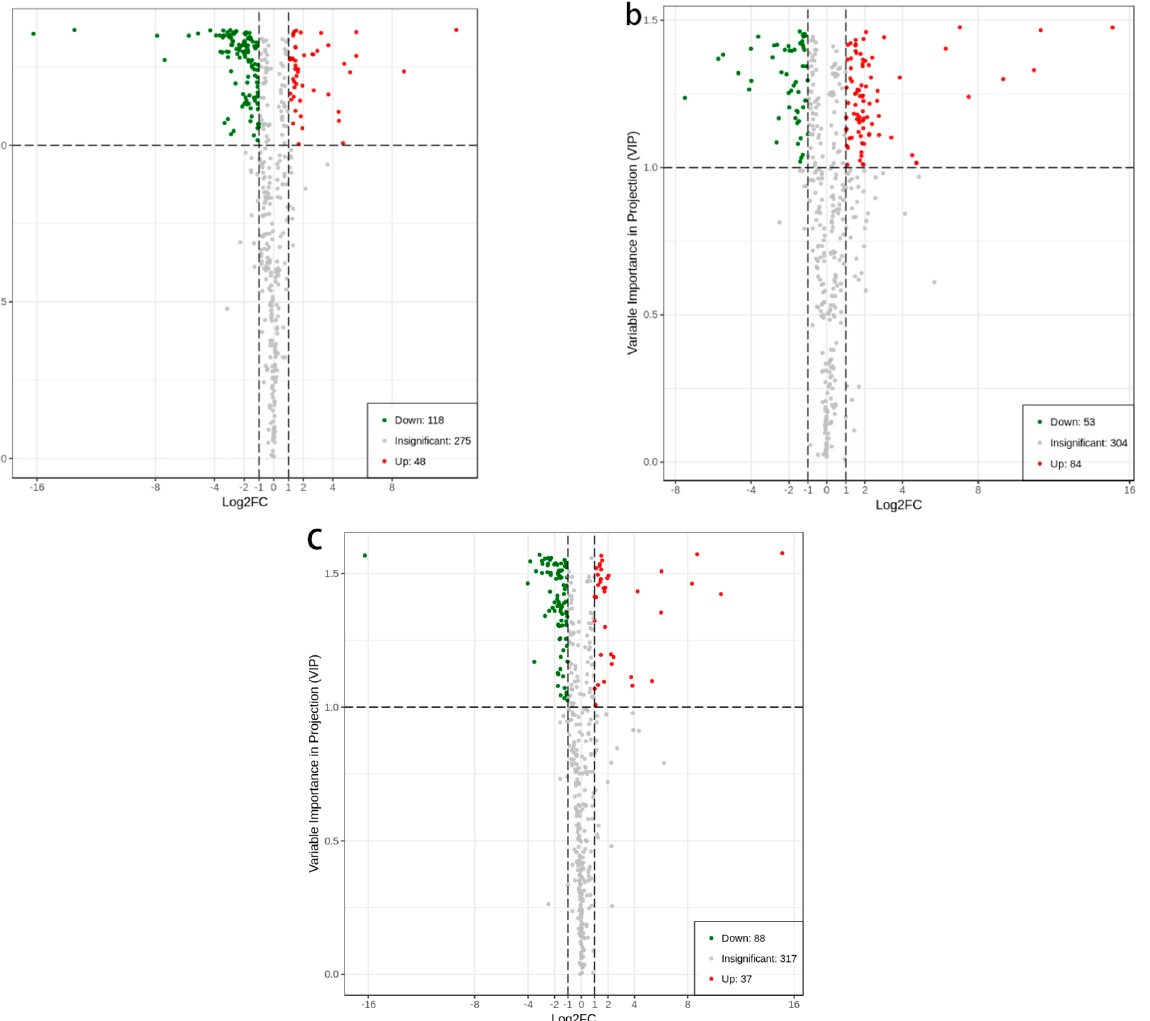
Figure 5. Volcano plots: ( a ) RS vs. GP; ( b ) GP vs. ZJ; ( c ) RS vs. ZJ. The green dots in the plots illustrated that the differential metabolites were significant and down-regulated, while the red dots illustrated that the differential metabolites were significant but upregulated, and the black dots illustrated that the metabolites could be detected but not significantly different.